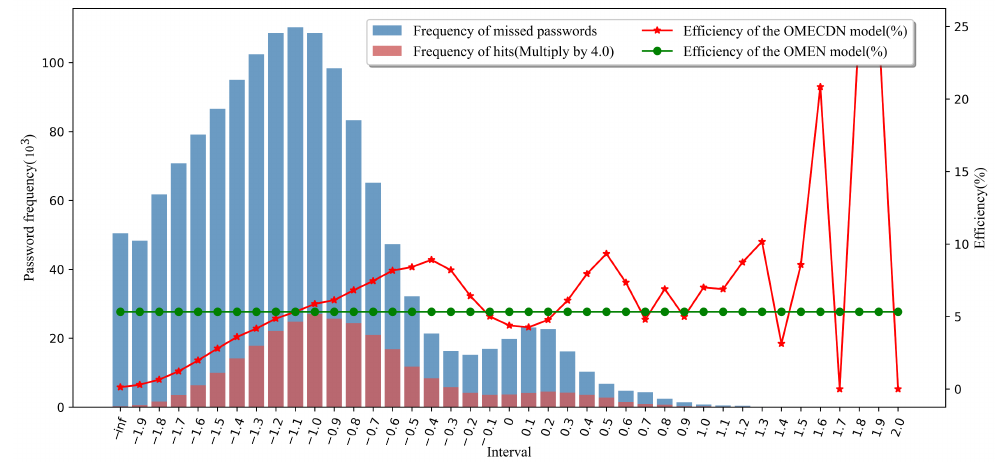
Figure 9. The distribution of 1 × 10 6 passwords scores generated by the OMECDN model.